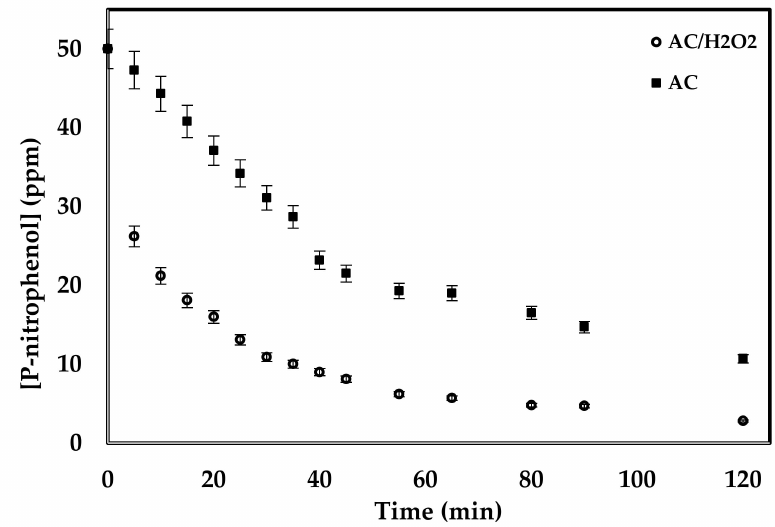
Figure 7. E ff ect of addition of H 2 O 2 on the decomposition of 4-nitrophenol under the conditions of 20 mL of 50 ppm 4-nitrophenol, 2 mL of H 2 O 2 , 0.3 g of AC, 25 ◦ C, 250 rpm for 2